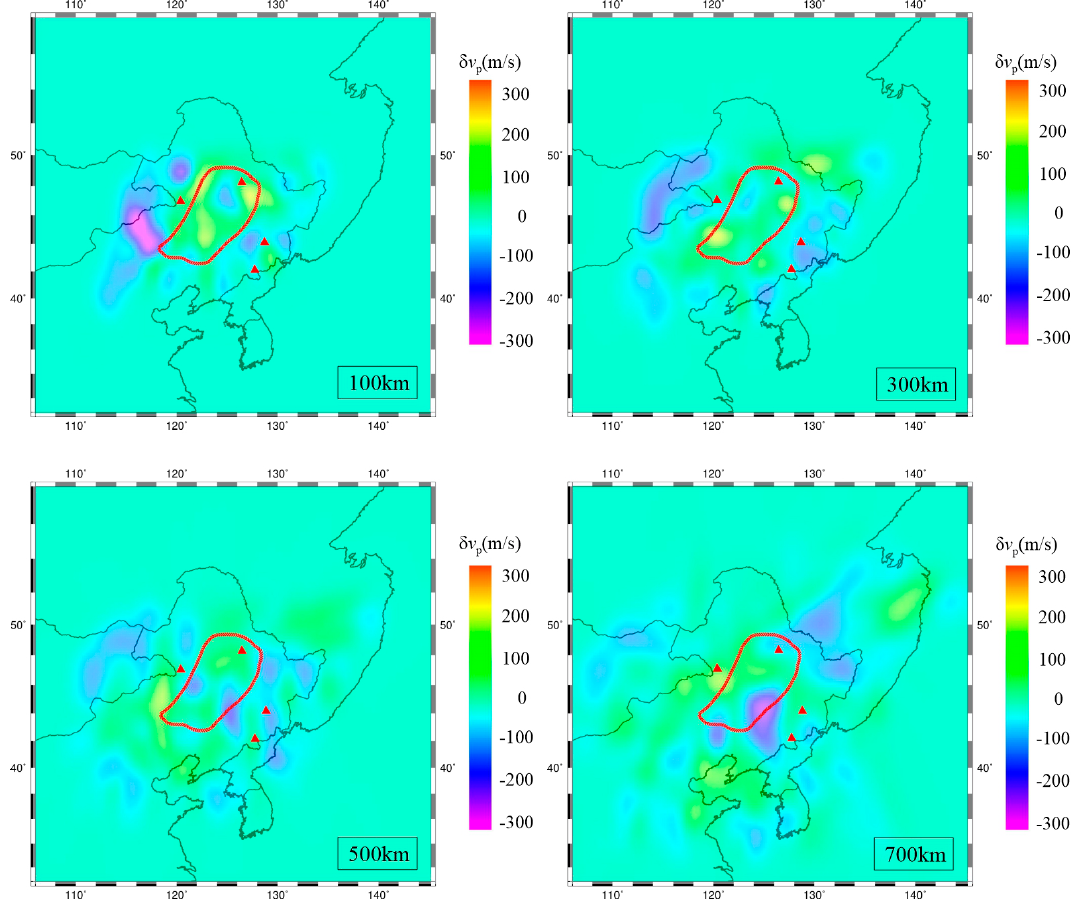
Figure 13. Horizontal section of P-wave velocity disturbance in the upper mantle of the study area (100–700 km, interval: 200 km).